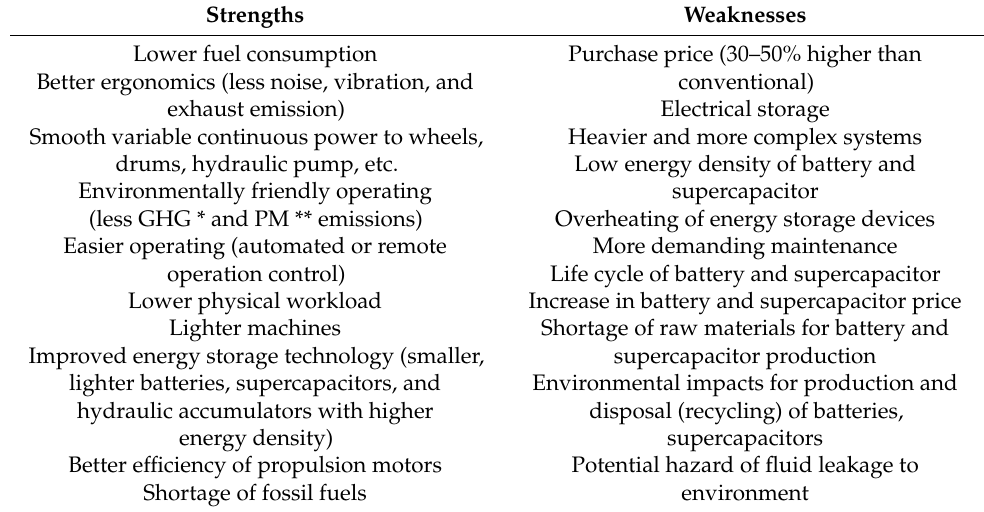
Table 2. Strengths and weaknesses of hybrid machines in